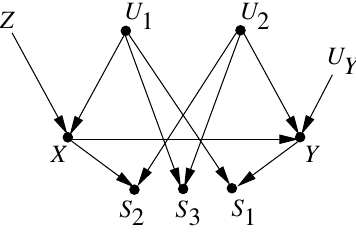
Figure 4: Model in which conditioning on S 2 induces selection bias, conditioning on S 3 induces confounding bias, and conditioning on S 1 induces